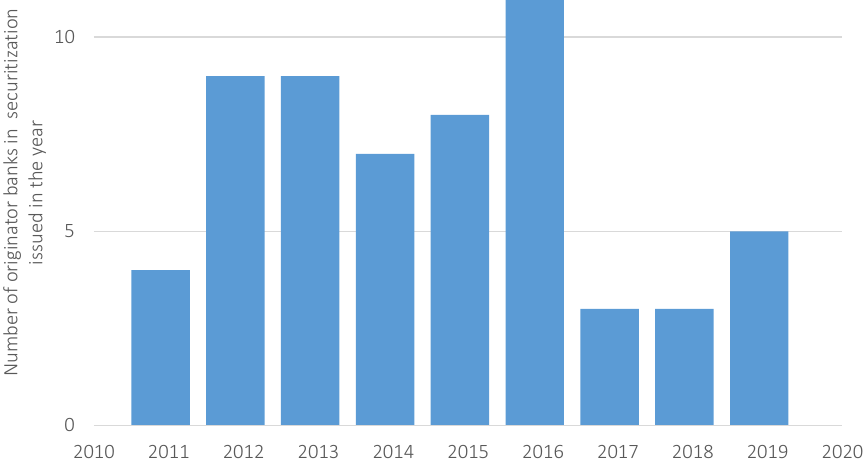
Figure A5. Securitization dynamics in Italy (number of originator banks issuing ABS) Table A6. Logit estimation for SME, RMBS and Any-sector securitizations (t-statistics in parentheses)